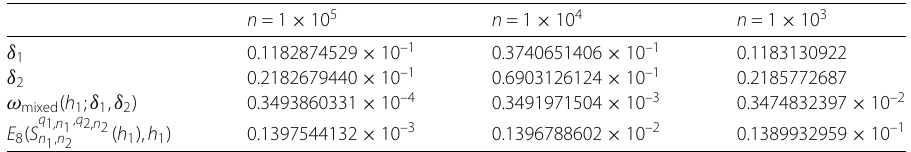
Table 8 The approximation error of B